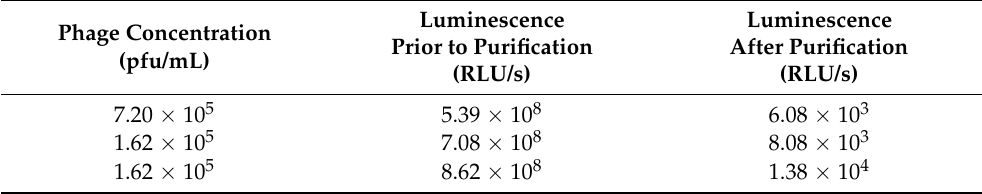
Table 2. Luminescence in Φ V10 nluc phage preparations before and after purification by centrifugal filtration. Luminescence (RLU/s) was measured in 10 µ L of Φ V10 nluc phage preparation before and after purification using the Amicon ® centrifuge filter to remove the NanoLuc ® luciferase. Luminescence Phage Concentration Prior to Purification (pfu/mL)